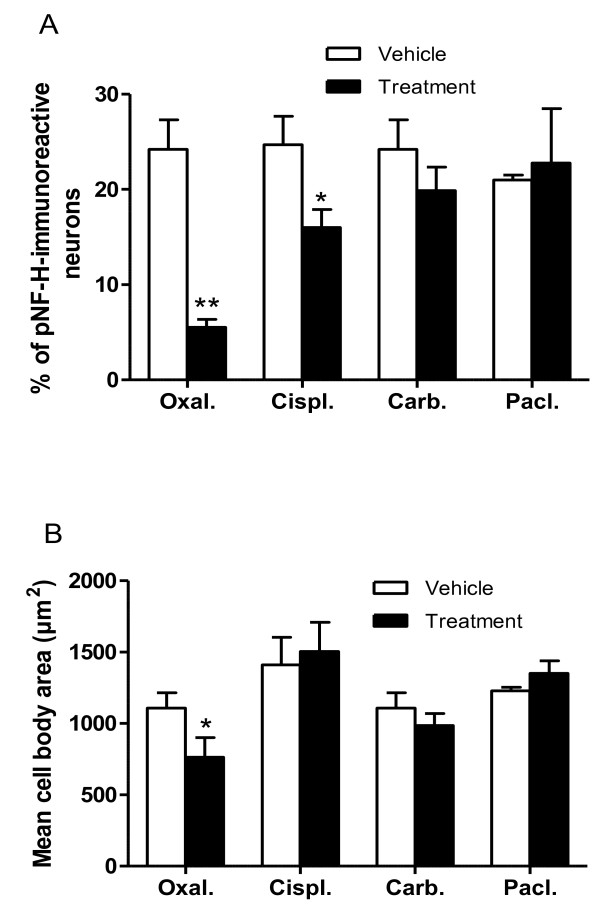
Comparative effect of anticancer drugs on neuronal pNF-H immunoreactivity. DRG were analysed after multiple-dose treatment with maximally tolerated doses of oxaliplatin (Oxal; 1.85 mg/kg/dose twice per week for 8 weeks), cisplatin (Cispl; 1 mg/kg/dose twice per week per 8 weeks), carboplatin (Carb; 8 mg/kg/dose twice per week per 8 weeks) and paclitaxel (Pacl; 12.5 mg/kg/dose once per week for 9 weeks). Bars represent the mean and standard deviation of 3 to 6 animals, * P < 0.01.